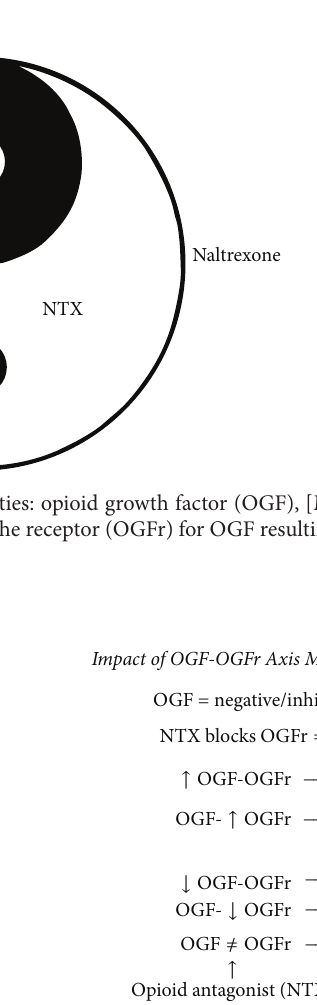
Figure 2: Ways in which the relationship between OGF, OGFr, and NTX can be manipulated to impact cell